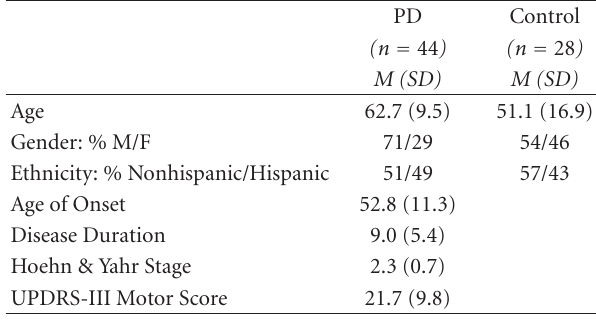
Table 1: Clinical Demographic Data for Sample.